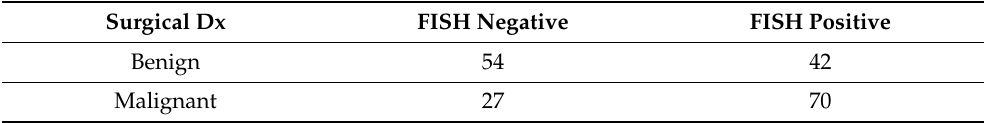
Table 2. Correlation of FISH and final surgical pathology